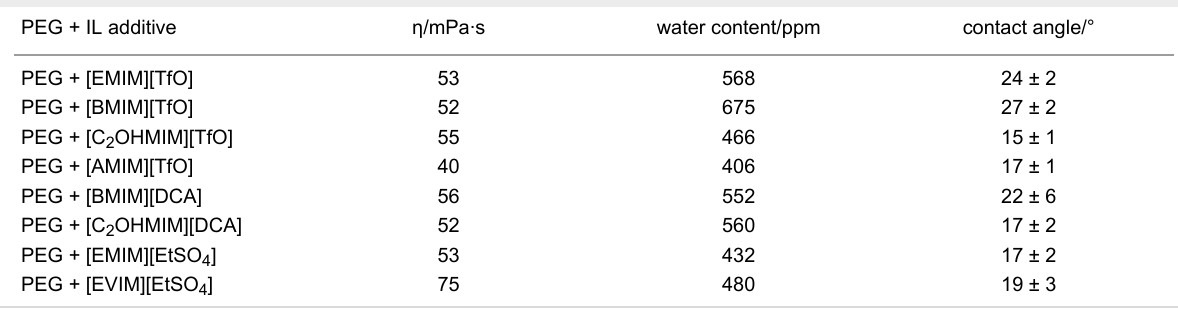
Table 2: Viscosity, η , at 25 °C, water content and contact angle of PEG + IL mixtures. PEG + IL